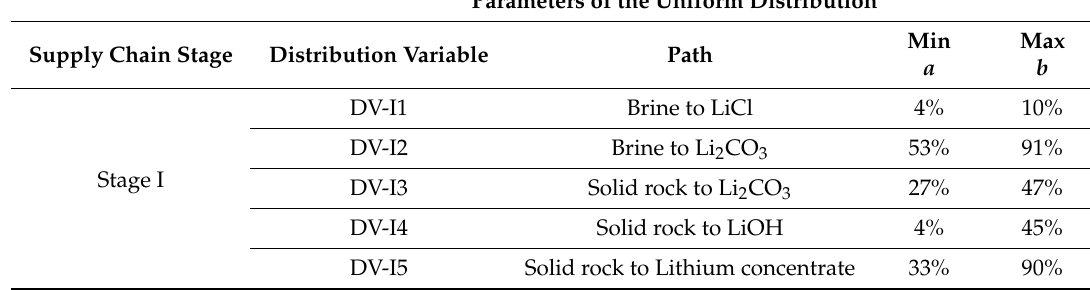
Table 2. Maximum and minimum values for the uniform distribution in the first stage of the supply chain. The paths extend from resource mining to chemical